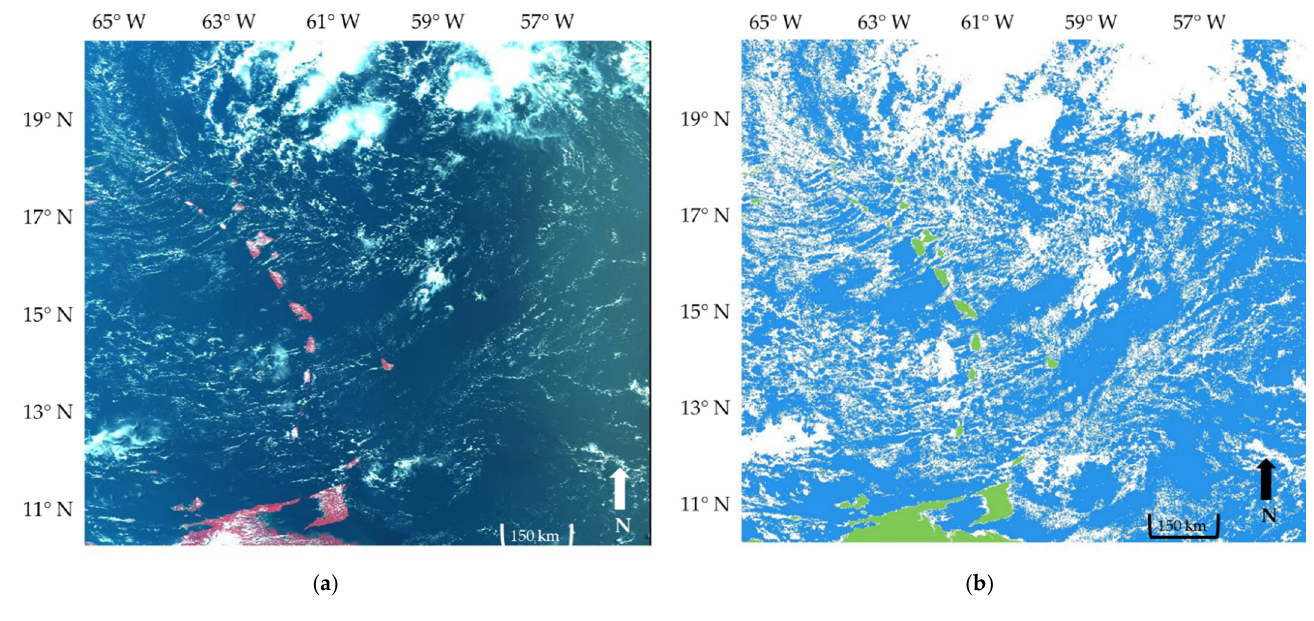
Figure 6. Data acquired by Sentinel-3/OLCI on 8 July 2017 at 13:00 ( a ) Level-1 data in NIR-G-B composite; ( b ) Water-land-cloud mask . Pixels containing land are in green, cloud-free pixels are in blue and cloud pixels are in white.